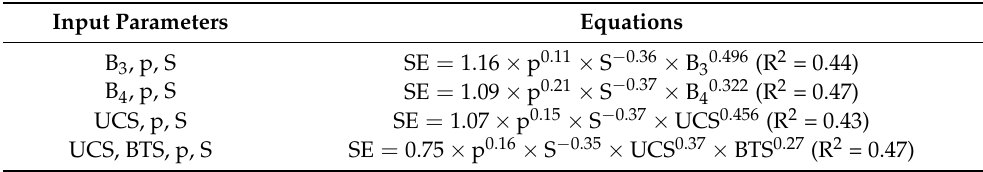
Table 6. Prediction models for specific energy under optimum